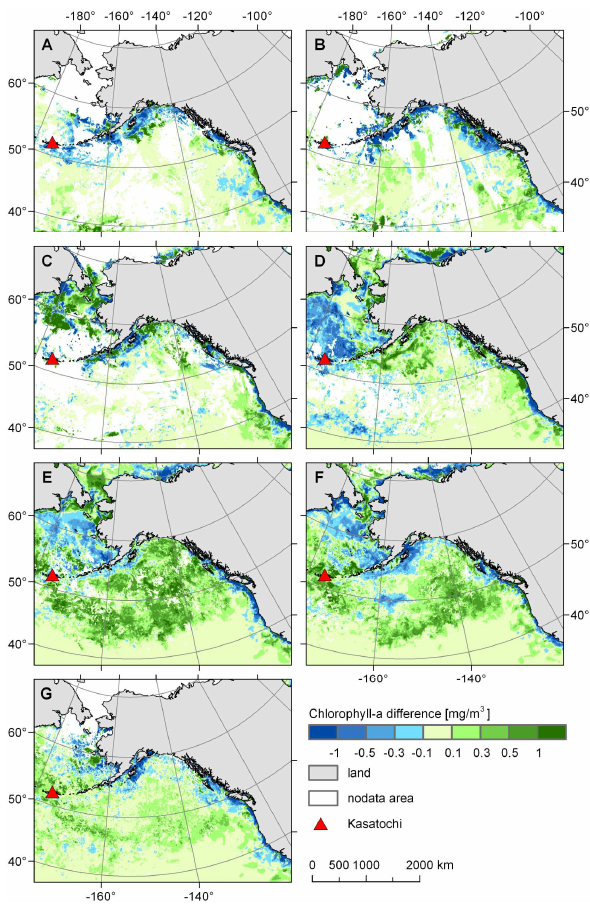
Fig. 3. MODIS Aqua chlorophyll- a [mg/m 3 ]: monthly mean 2008 minus average monthly mean 2002–2007. (A) April, (B) May, (C) Figure 3. MODIS Aqua chlorophyll-a [mg/m3]: monthly mean 2008 minus average monthly 3 June, (D) July, (E) August, (F) September, (G) mean 2002–2007. A: April, B: May, C: June, D: July, E: August, F: September, G: October. 4